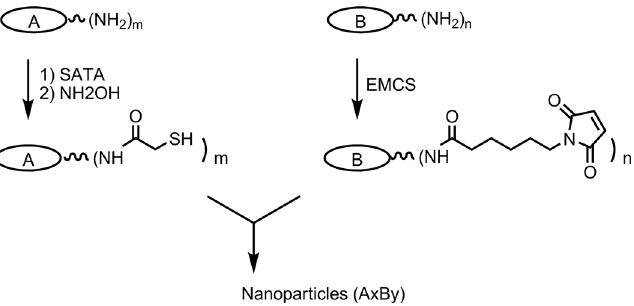
Fig 1. Multiple thiol or maleimide linkers are non-specifically attached to lysine amines on the protein molecules by treatment with excess SATA or EMCS. Particles composed of A and B are formed by mixing thiolated protein with maleimide-modified protein.